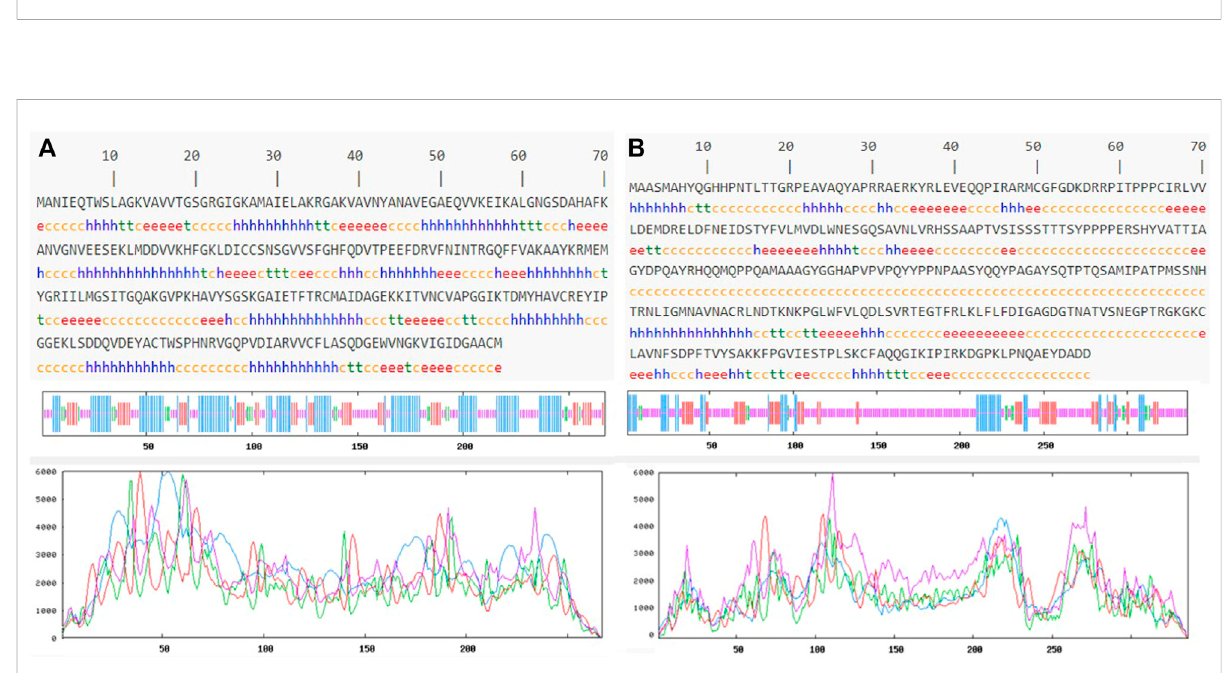
FIGURE 3 Relative quanti fi cation of brn1 , velB , pks18 , and clm1 gene expression in C. lunata (normalised to the house-keeping gene GAPDH). Data were reported as mean of fold changes with standard deviation from two independent experiments ampli fi ed in triplicate. p ≤ 0.05 was considered statistically signi fi cant.